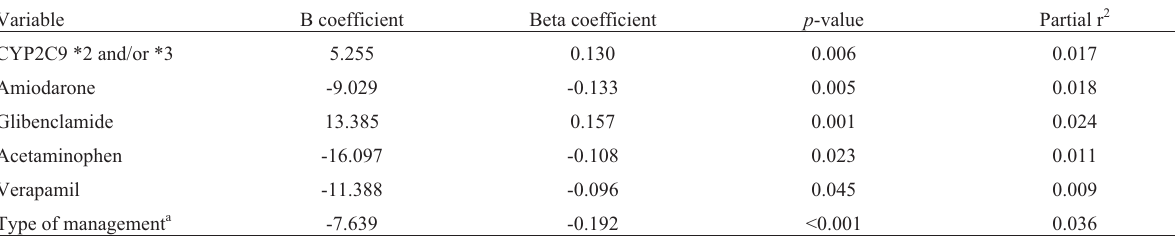
Table 3 - Final regression model for